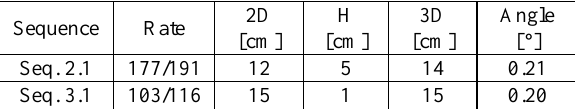
Table 2. Median differences between reference orientation parameters and calculated values